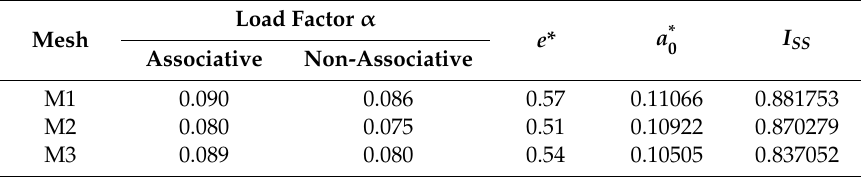
Table 2. Results for the out-of-plane collapse mechanisms of the F3 façade.